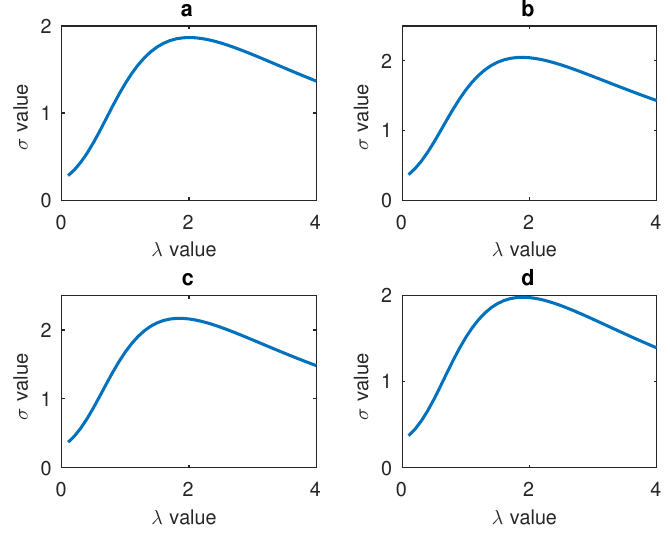
Figure 8. ( a ) Relationship between the mouth’s λ and σ ; ( b ) Relationship between the left cheek’s λ and σ ; ( c ) Relationship between the forehead’s λ and σ ; ( d ) Relationship between the right cheek’s λ and σ